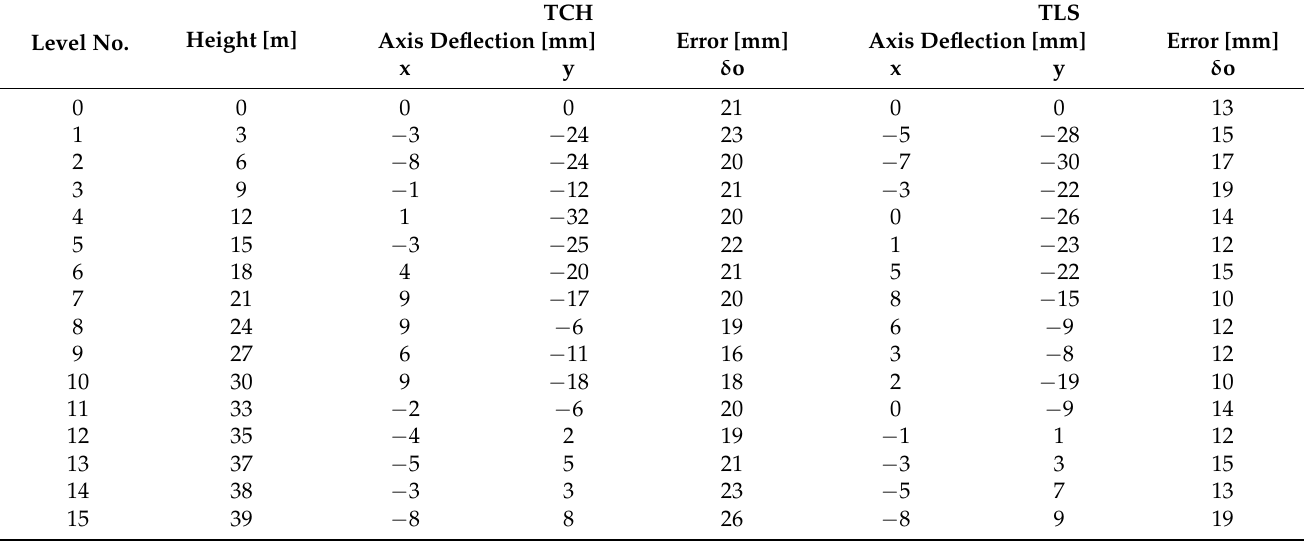
Table 5. Horizontal deflections of the cooling